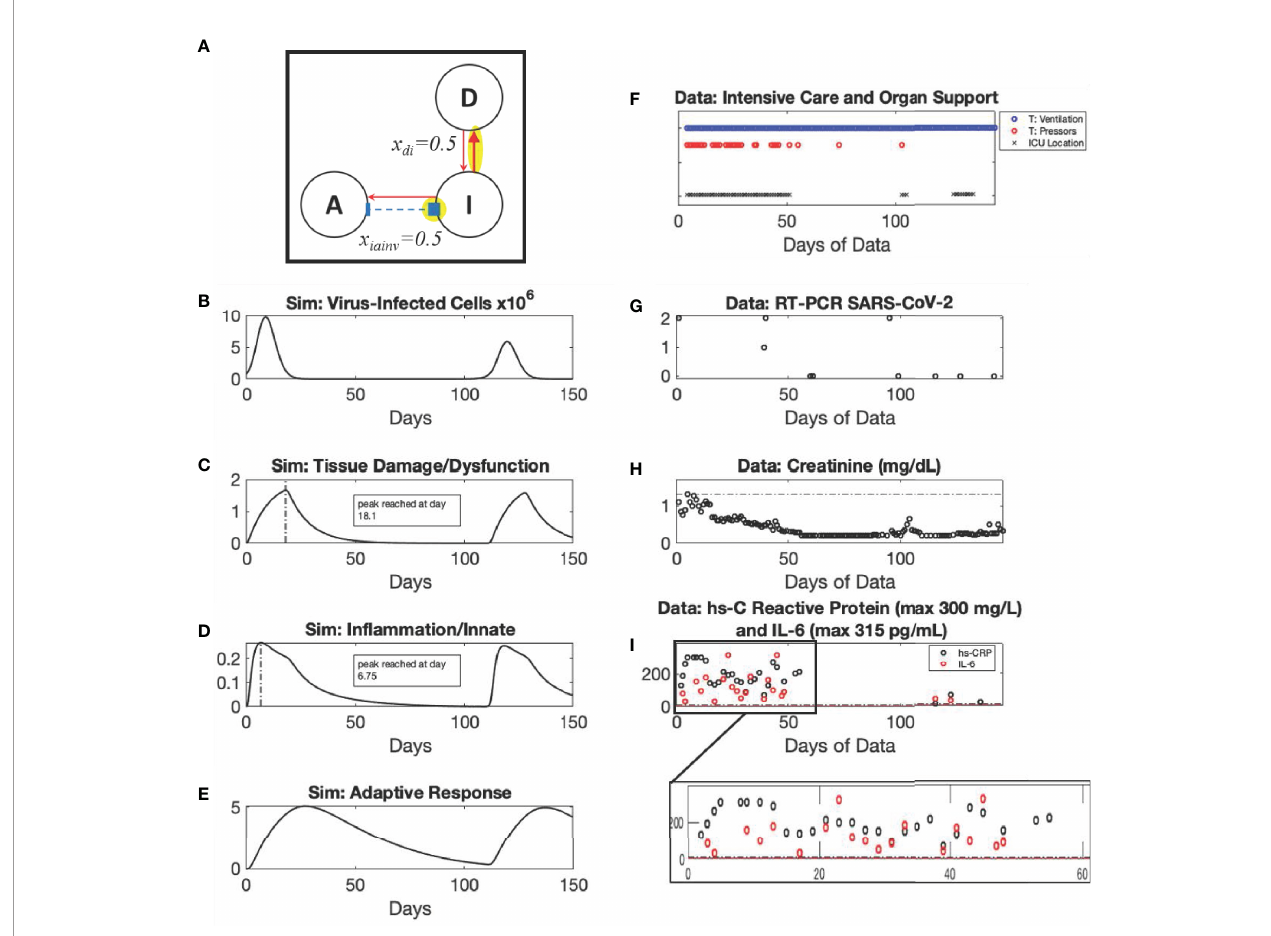
FIGURE 6 | Recrudescence archetype: simulation vs . patient data. Using modi fi ed values of parameters x iainv and x di compared to the Recovery archetype, Mild scenario as shown in the diagram (Panel A ), simulated dynamics are shown of C V (Panel B ), (Initialized with a C V =8x10 5 virus-infected cells), D (Panel C ), I (Panel D ), and A (Panel E ). Panels (F – I) show data from a patient in their 60s with hypertension and no known sick contacts who presented after 4 days of fever, chills, malaise , and headache with mild hypoxemia (oxygen saturation 95%) and mild opacities on chest radiograph, found to be SARS-CoV-2 PCR positive. The patient ’ s oxygen requirement steadily increased over four days and they required mechanical ventilation for acute respiratory distress syndrome. While the patient was still ventilator-dependent, they were able to be de-escalated from the intensive care unit at Hospital Day 50 and required a brief return to intensive care with vasopressor support at day 103. The patient was still ventilator-dependent by the time of their discharge to a long-term acute care (ventilator-capable) facility on hospital day